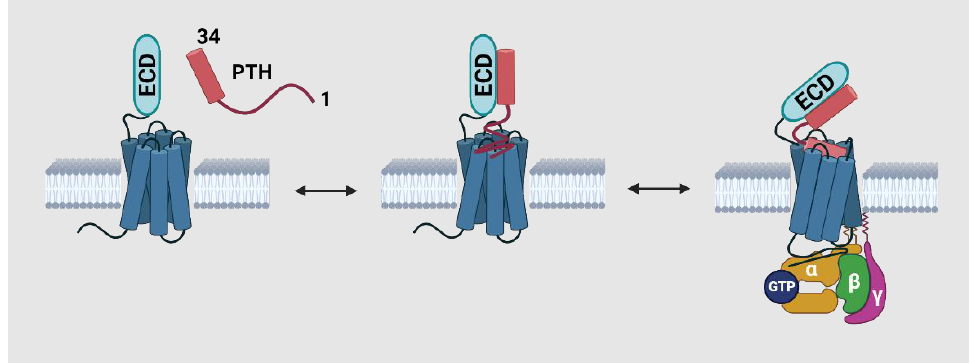
Figure 3. The two-site model describes the interaction between PTHrP/PTH and PTH1R interaction mechanism. In this model, PTHrP (or PTH) binds to the extracellular domain (ECD) of the PTH1R at the juxtamembrane region, and then interacts with the transmembrane domain of the receptor to induce intracellular signaling. This model is supported by experimental evidence showing that mutations in the juxtamembrane region of PTH1R impair the binding of PTHrP to the receptor and downstream signaling [52].